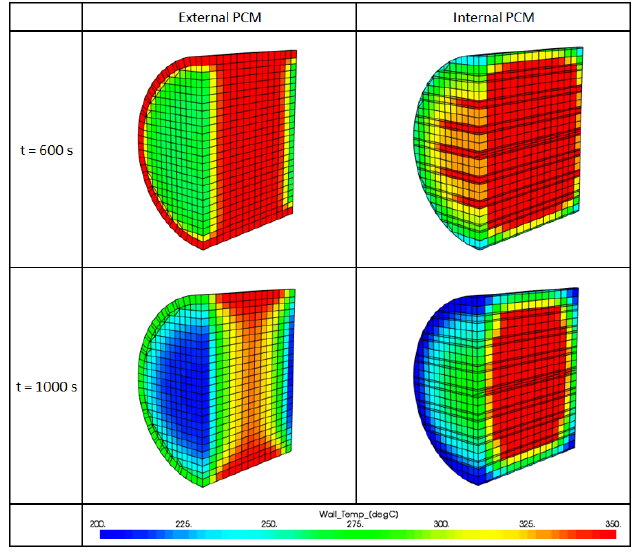
Figure 17. Three-dimensional temperature field of the monolith for internal and external PCM configuration during the cooling-down process under zero-flow conditions. configuration during the cooling-down process under zero-flow